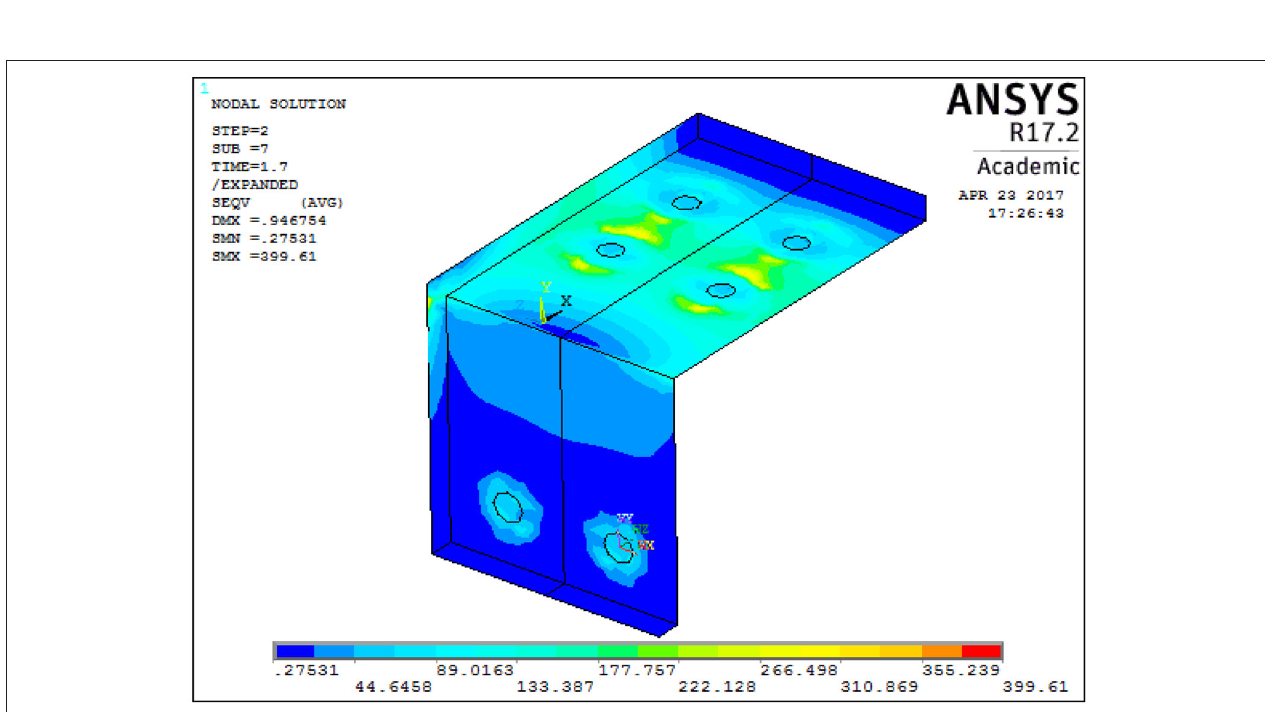
FIGURE 6 | Von Mises stress distribution in the seat angle for case 1.